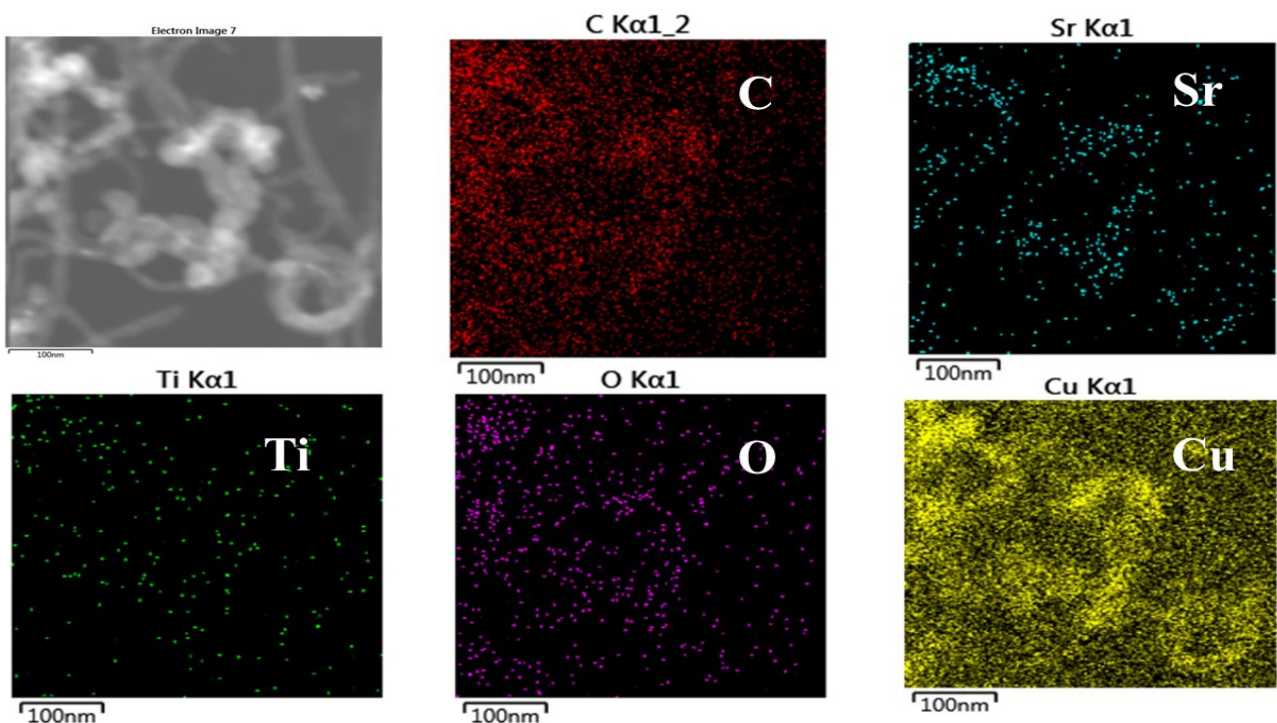
Figure 5. DF-STEM micrographs and EDX element mapping images of 3% CuO/STO/MWCNTs.